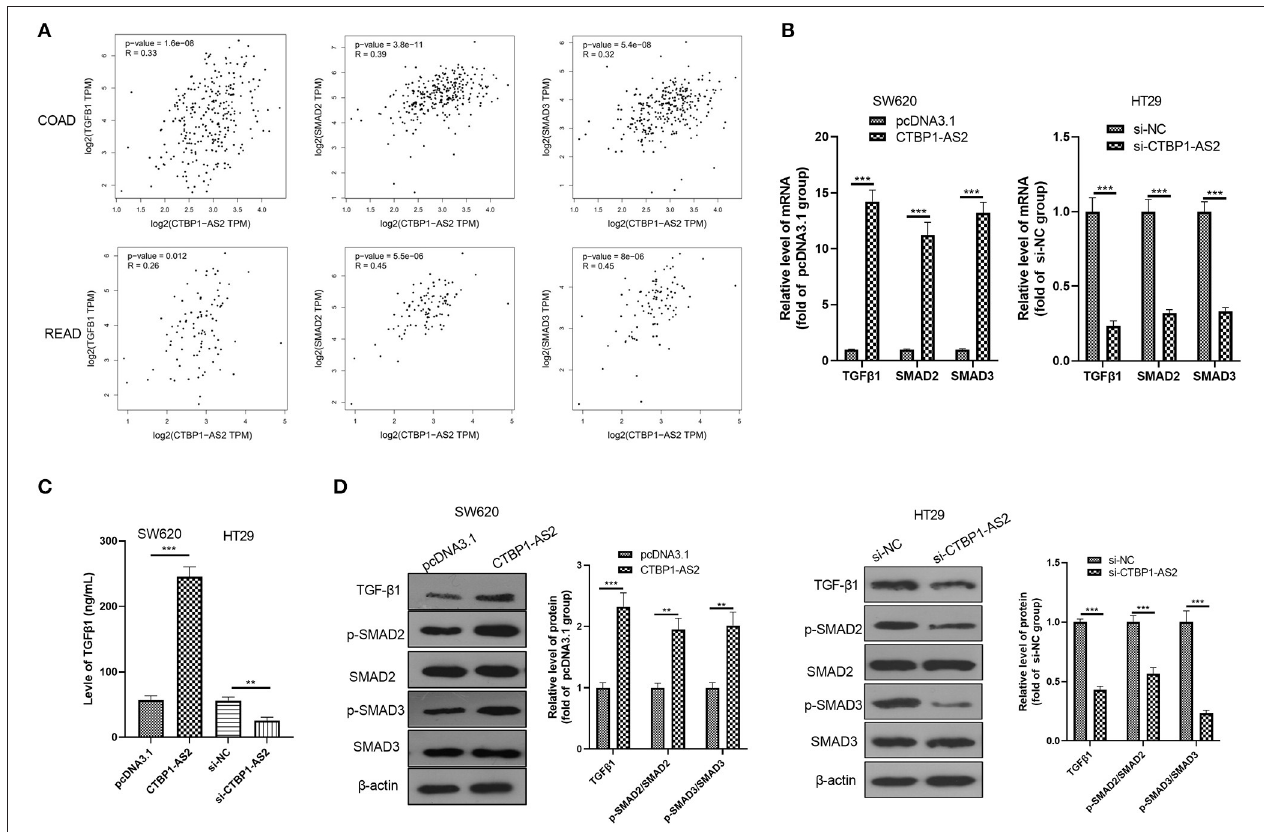
FIGURE 3 | Regulation of CTBP1-AS2 on CRC proliferation, apoptosis, and invasion. (A) SW620 cells transfected with CTBP1-AS2 overexpression plasmids or pcDNA3.1, and HT29 cells transfected with si-CTBP1-AS2 or si-NC. Performing RT-PCT to measure CTBP1-AS2 expression in the two cell lines. (B) Incubation of SW620 and HT29 cells in the 96-well plates for different time points (24, 48, and 72h). Use of CCK-8 assay to examine cell proliferation with different levels of CTBP1-AS2. * p < 0.05, ** p < 0.01, *** p < 0.001 vs. pcDNA3.1 group or si-NC group. (C) Examination of cell proliferation of SW620 and HT29 cells through colony formation experiments. (D) Detection of apoptosis-related proteins caspase-3 and Bax expressions in SW620 and HT29 cells using Western blotting. (E) Use of the Transwell method to measure cell invasion of SW620 and HT29 cells. ** p < 0.01, *** p < 0.001. N = 3. CCK-8, cell counting kit-8; CRC, colorectal cancer; RT, reverse transcription; si-NC, small interfering RNA negative